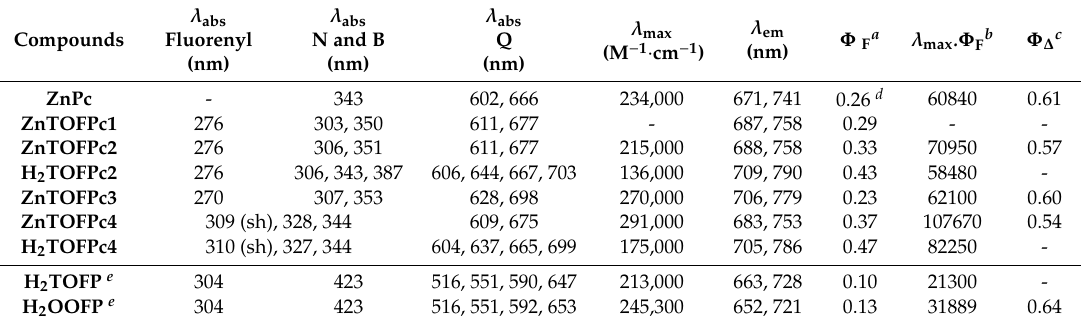
Table 1. Photophysical properties of the new phthalocyanines ZnTOFPc1 – 4 , H 2 TOFPc2 , and H 2 TOFPc4 , and of the reference ZnPc in THF at 293 K. Related data are also given for selected porphyrin dendrimers in CH 2 Cl 2